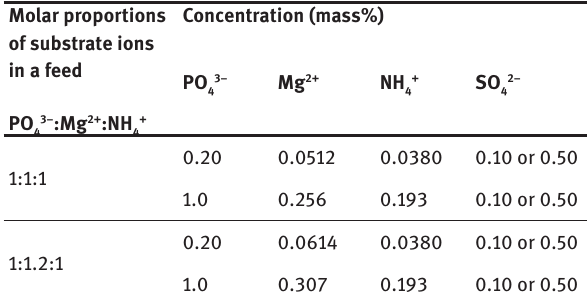
Table 1: Chemical composition of solutions feeding the continuous DT MSMPR crystallizer. Molar proportions of substrate ions in a